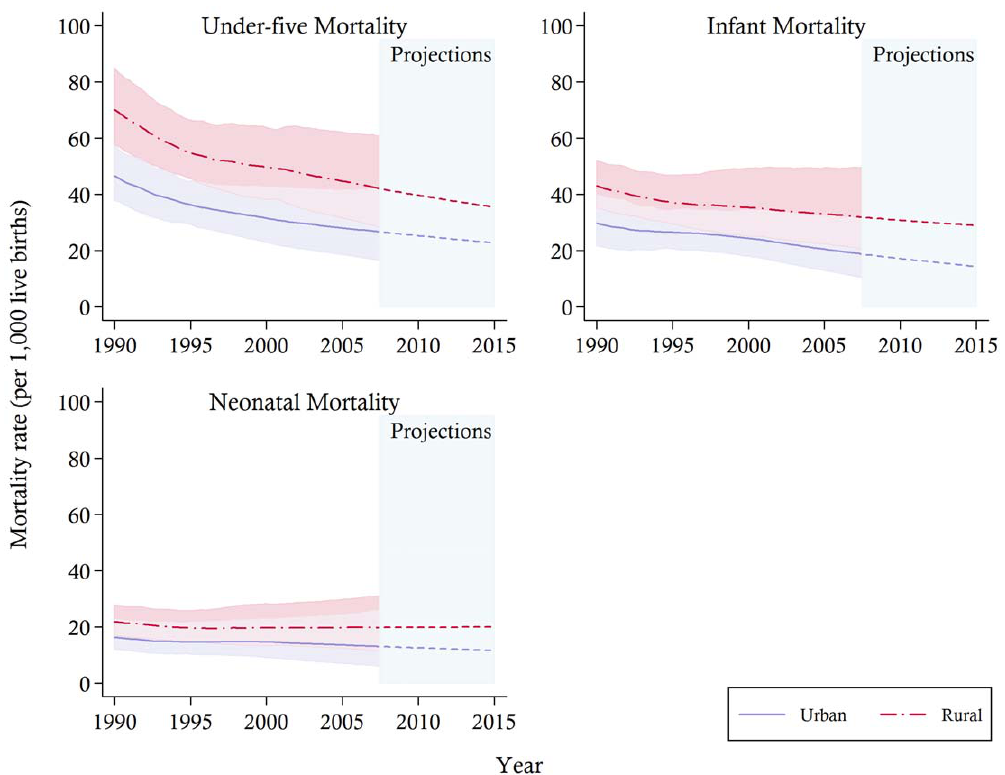
Figure 2. Under-five, infant, and neonatal mortality rates (per 1,000 live births) by rural and urban location: actual 1990–2007; projected to 2015. Notes : Data are from Demographic Health Surveys 1993, 1998, 2003, and 2008. The solid and semi-broken lines represent the mortality estimates calculated using direct methods, while the shaded area signifies the corresponding 95% confidence intervals. DHS, Demographic Health Survey.